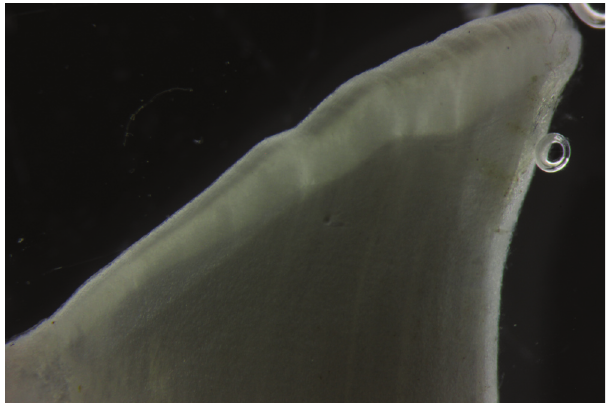
Figure 1. Sectioned vertebra from Atlantic Sharpnose Shark Rhizoprionodon terraenovae L5242. Consensus band count was 20 band pairs (age = 18.5